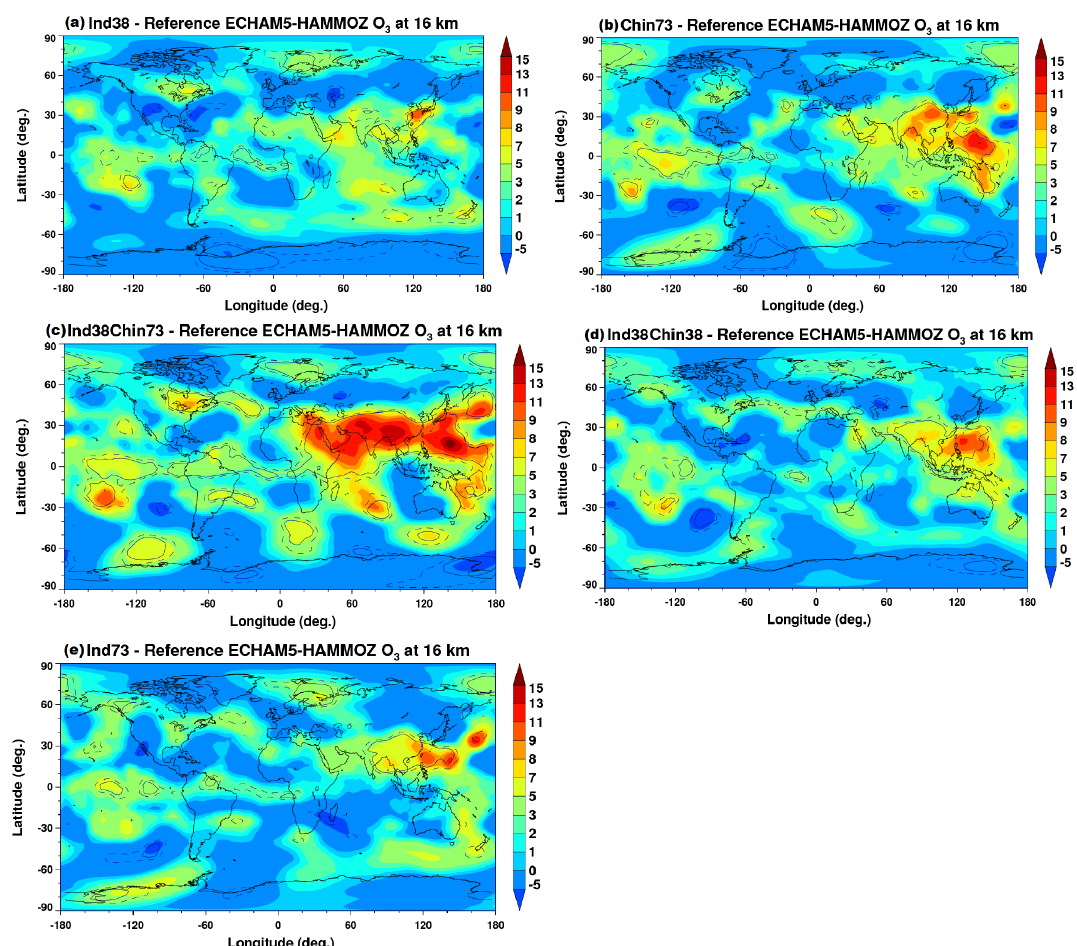
Figure 9. Percentage change in ECHAM5-HAMMOZ ozone at 16km, as obtained from (a) Ind38, (b) Chin73, (c) Ind38Chin73, (d) Ind38Chin38 and (e) Ind73 simulations. Solid black line indicates the 95% Student’s t test confidence interval while the dashed line indicates 90% confidence